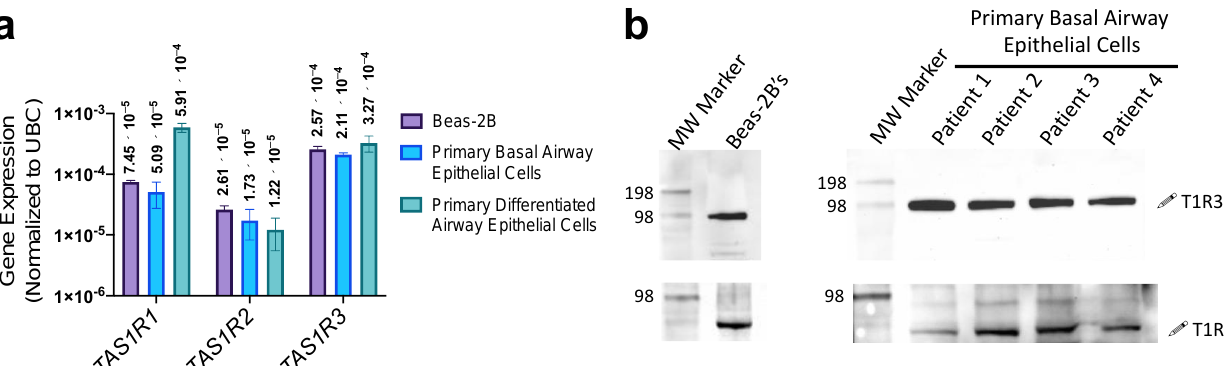
Figure 1. T1R expression in airway epithelial cells. ( a ) qPCR revealed TAS1R1, TAS1R2, and TAS1R3 transcript expression (relative to housekeeping gene UBC) in Beas-2B, basal airway epithelial cells, and differentiated airway epithelial cells. ( b ) Both T1R1 and T1R3 proteins (predicted molecular weight of ~93 kDa) were detected via Western blot using 60 µg protein/lane of Beas-2B or primary basal epithelial cell extract. The visualized protein band representing T1R1 expression migrated slightly lower than predicted 93 kDa but was conserved across cell lines tested. This may be due to incomplete denaturation of the samples prior to SDS-PAGE; freezing or boiling samples for downstream analysis of GPCR’s often leads to formations of aggregates, therefore these samples were processed on the same day without overnight storage or complete denaturation. Bar graphs display mean ± SEM from three experiments.